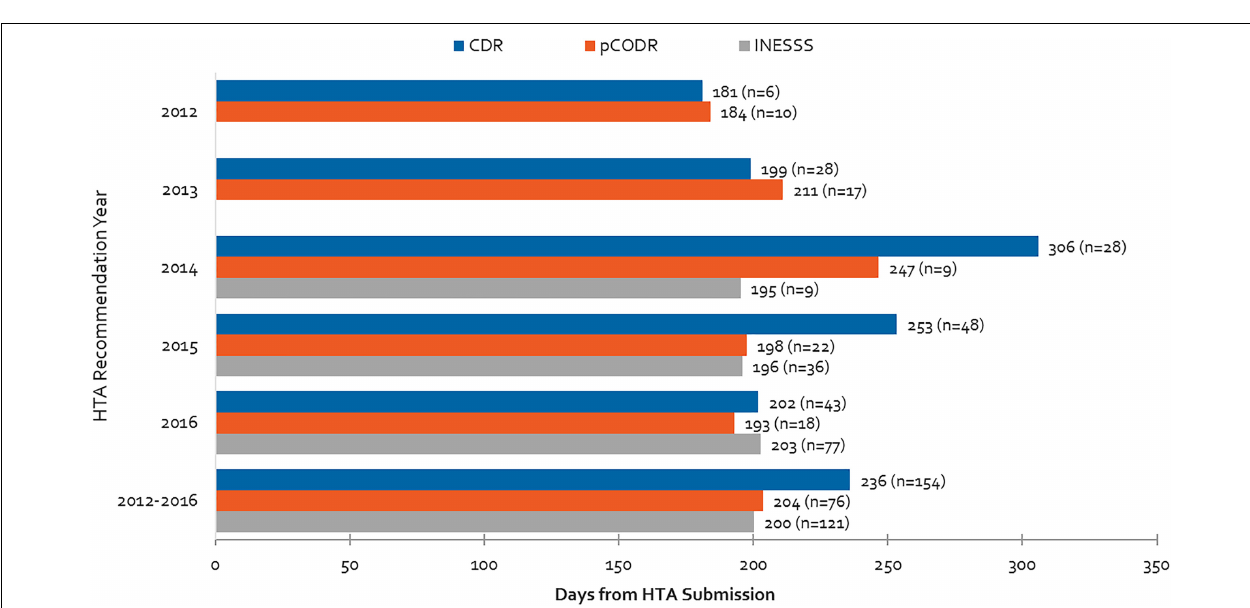
FIGURE 6 | Public reimbursement timelines for oncology vs. non-oncology products, and number of items listed (n), 2013-2014 and 2015-2016.